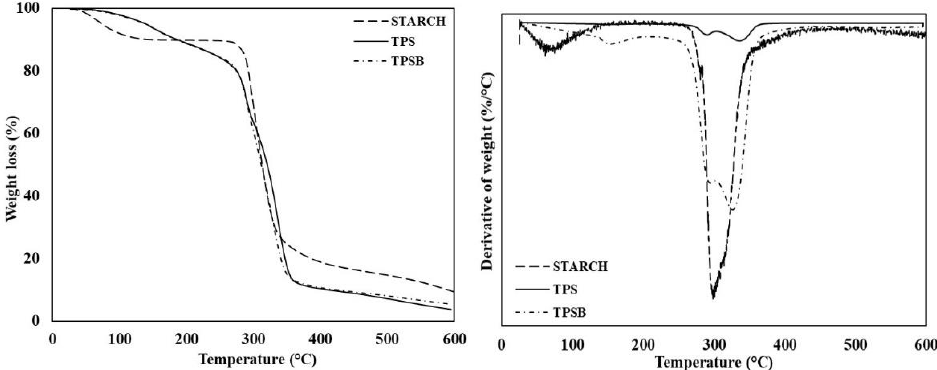
Figure 8. Thermal stability of APPS, TPS and TPSB.